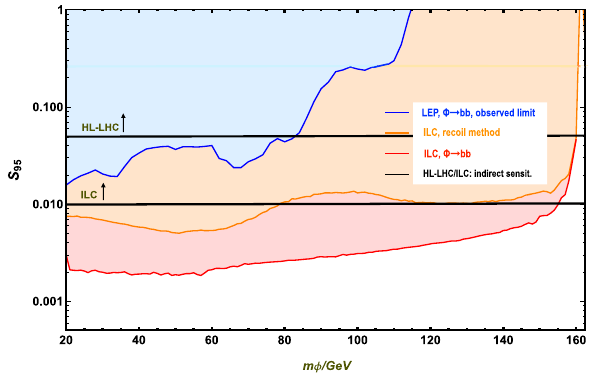
Fig. 3 Projections for the expected limits on S 95 at the ILC [19] with √ s = 250 GeV, L = 500 fb − 1 and polarised beams ( P e − = − 80% and P e + = + 30%) for the analysis using the decay φ → b ¯ b and for the recoil method analysis, based only on the recoil from the Z boson that is reconstructed from the Z → μ + μ − decay. The impact of the Higgs signal at 125 GeV is not shown. The ILC projections are compared with the observed limit at LEP from the φ → b ¯ b searches [1]. The solid horizontal lines denote the indirect sensitivities at the HL-LHC and the √ s = 250 GeV from the projection for the accuracies on the ILC with couplings of the observed Higgs boson at 125 GeV [27] (see